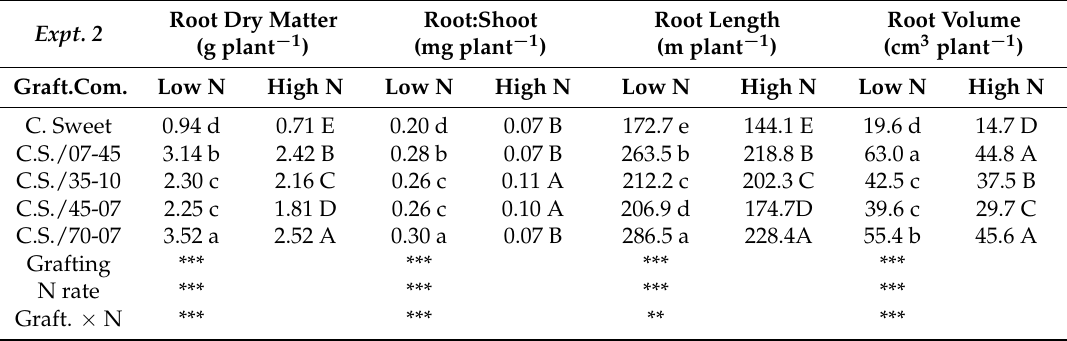
and high (3.0 mM) N supply in Expt. 2